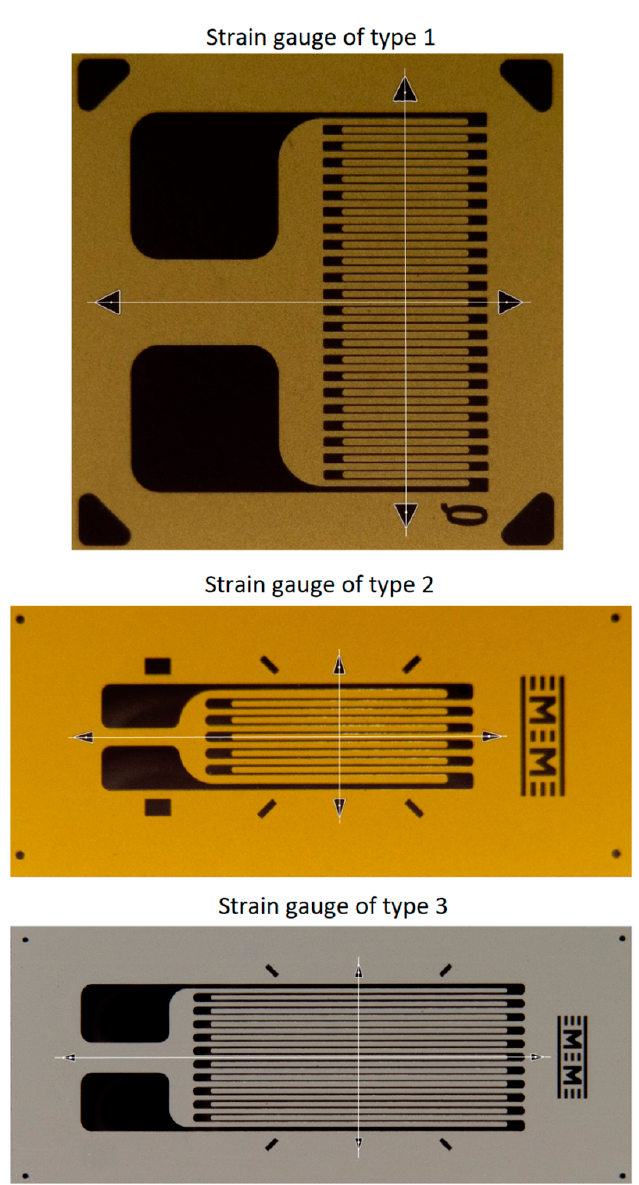
Figure 16. The directions parallel and perpendicular to the SG filaments, automatically detected.